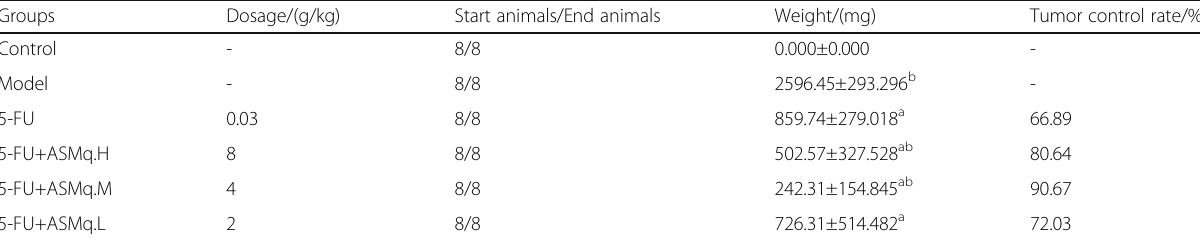
Table 3 Inhibitory effect of Abnormal Savda Munziq on the growth of transplanted cervical cancer tumors in mice when combined with 5-FU ( x ± s )